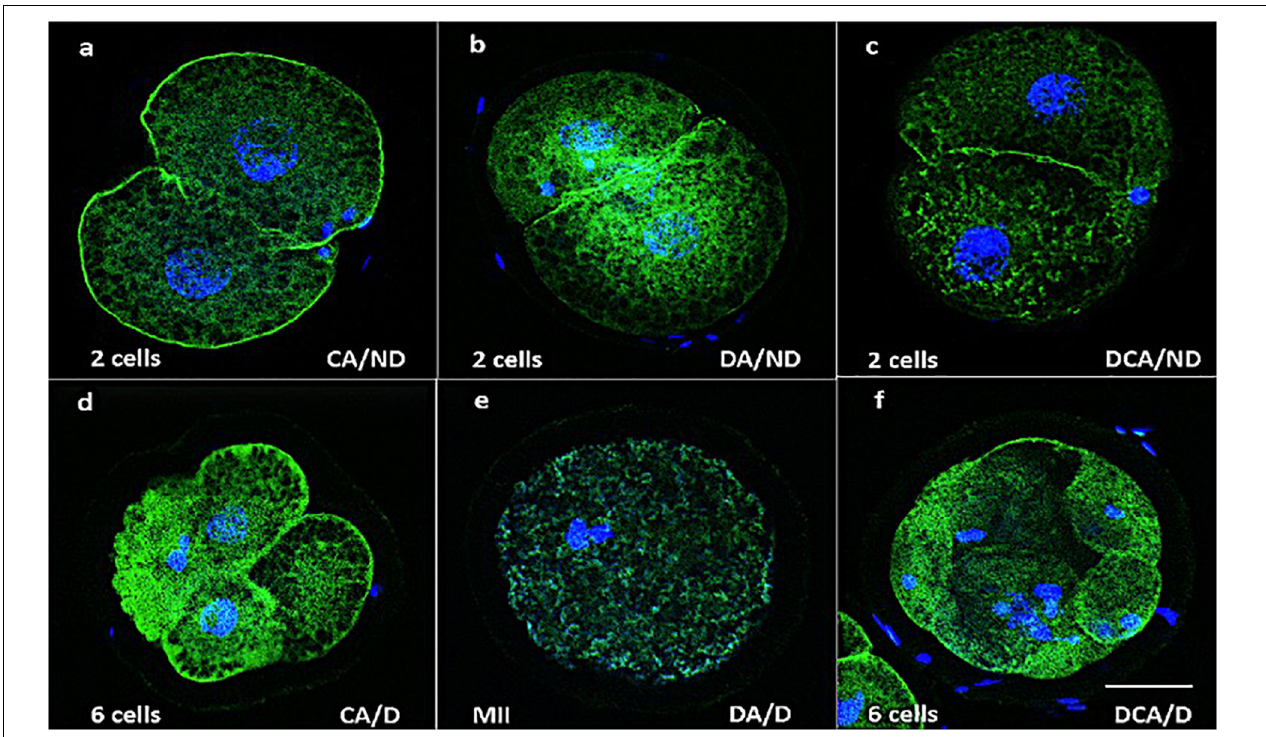
FIGURE 7 | Representative merged images of actin microfilaments (green) and chromatin (blue) in early ED. (a–c) Images correspond to embryos from fresh oocytes, and (d–f) images correspond to embryos from vitrified oocytes. (a) Cortical actin without damage (CA/ND); (b) dispersed actin without damage (DA/ND); (c) dispersed cortical actin without damage (DCA/ND); (d) cortical actin with damage (CA/D); (e) dispersed actin with damage (DA/D); (f) dispersed cortical actin with damage (DCA/D); 200 × , scale bar = 30 µ m.